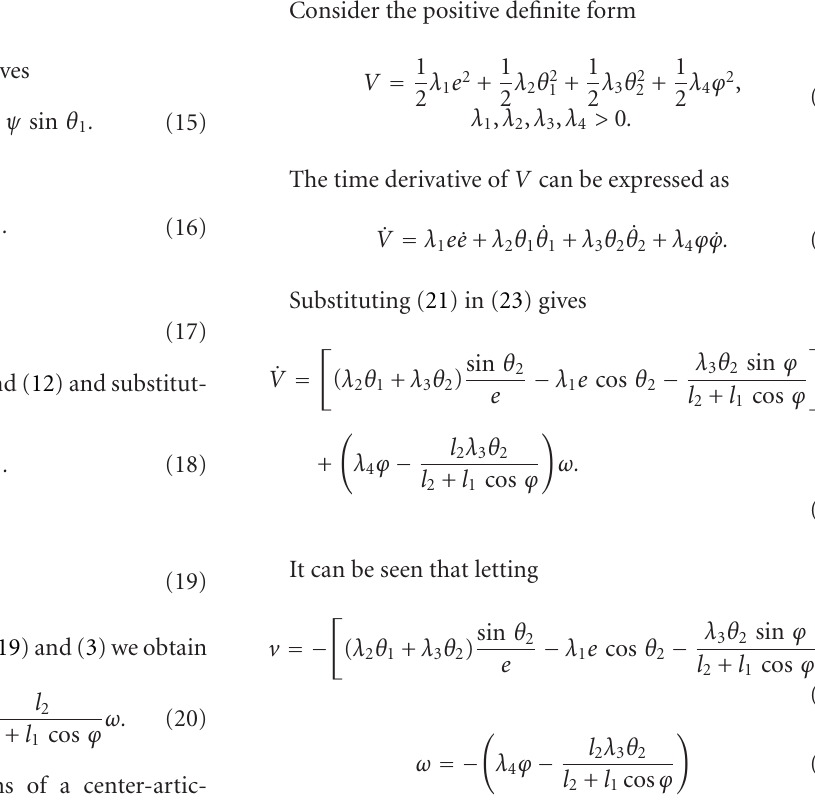
Figure 4: Diagram of a center-articulated mobile robot with respect to the target frame in polar